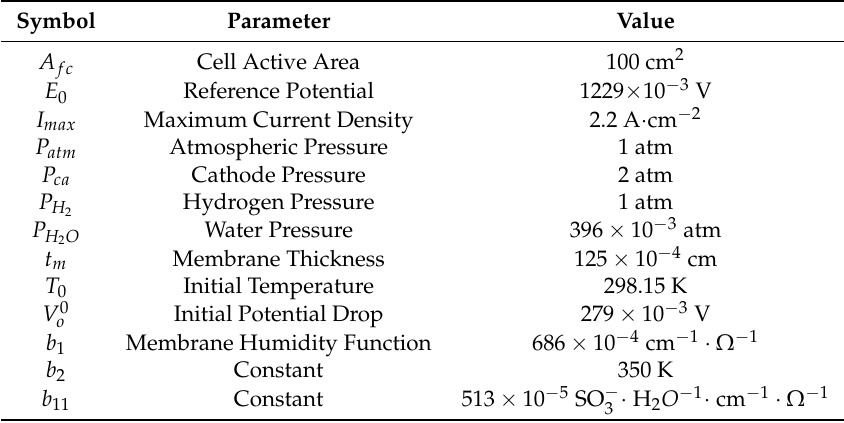
Table 1. Parameters for the PEMFC voltage model